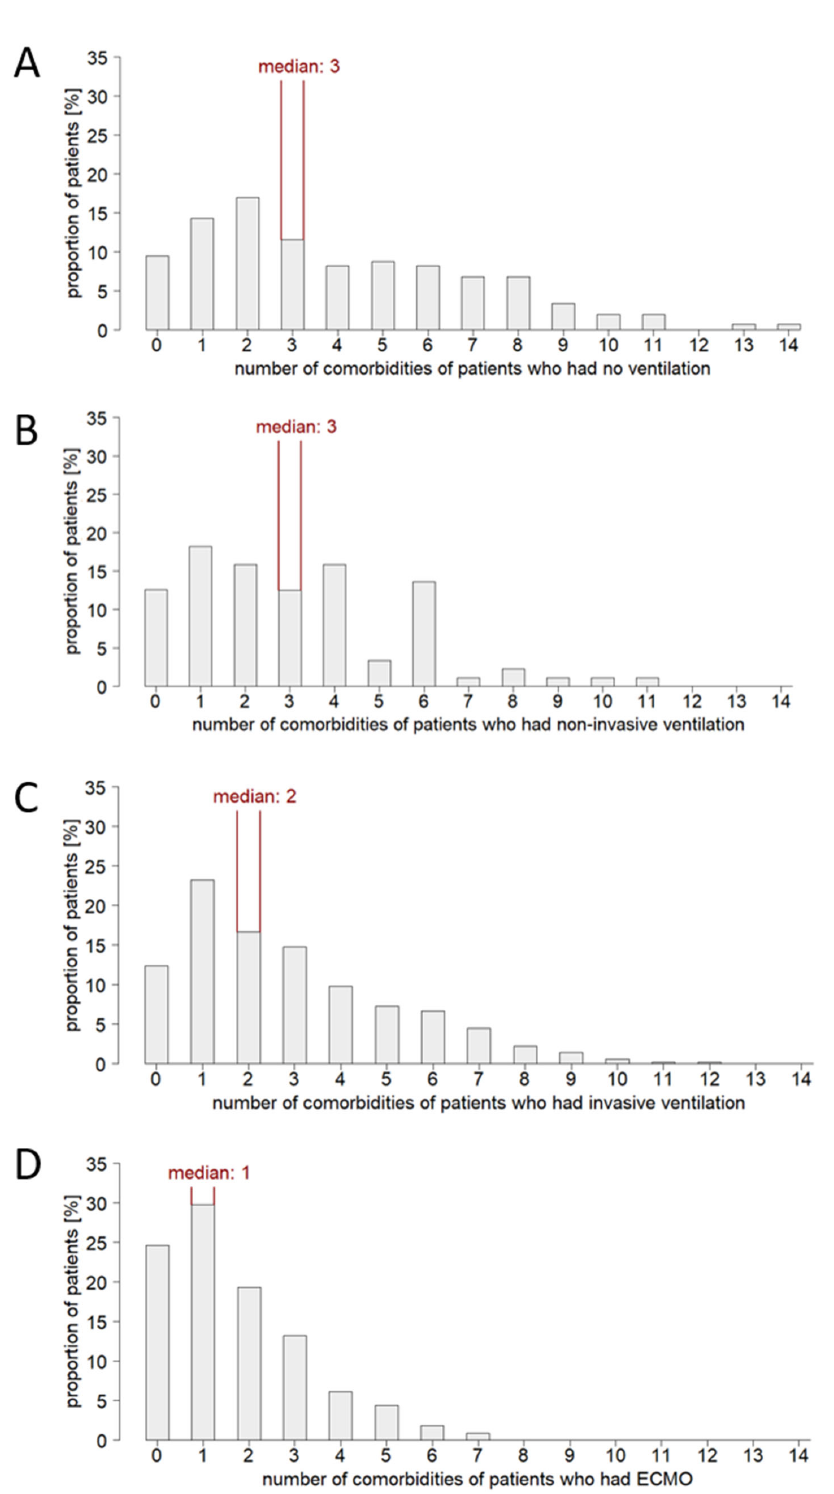
Figure 4. Distribution of the number of comorbidities in COVID ‐ 19 patients receiving intensive care. ( A ): Sub ‐ cohort of non ‐ ventilated patients ( n = 147), ( B ): sub ‐ cohort of non ‐ invasively ventilated patients ( n = 87), ( C ): sub ‐ cohort of invasively ventilated patients ( n = 492), ( D ): sub ‐ cohort of ECMO patients ( n = 114).